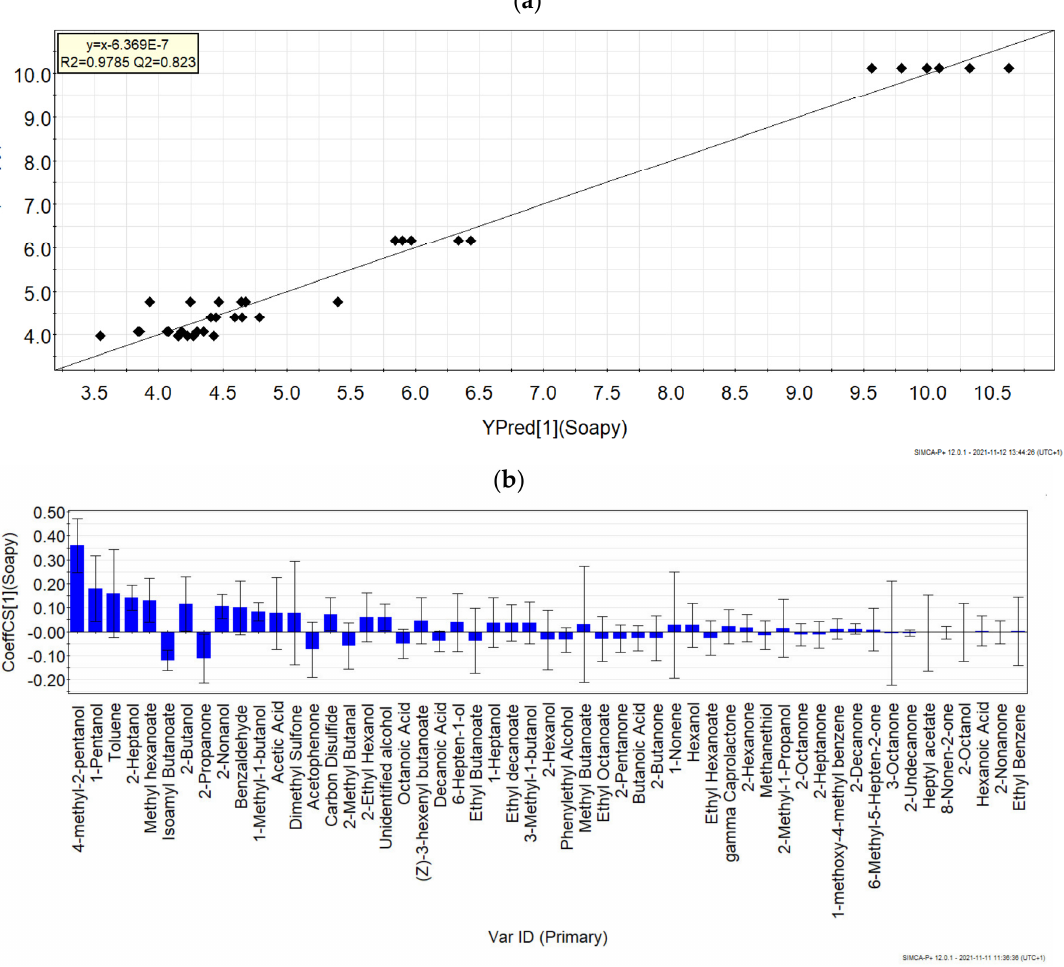
Figure 4. Regression model of the ‘soapy’ flavor attribute. ( a ) Plot of the observed versus predicted values of ‘soapy’ flavor perception. ( b ) Column plots of coefficients, referring to scaled and cantered data, with jack-knife uncertainty